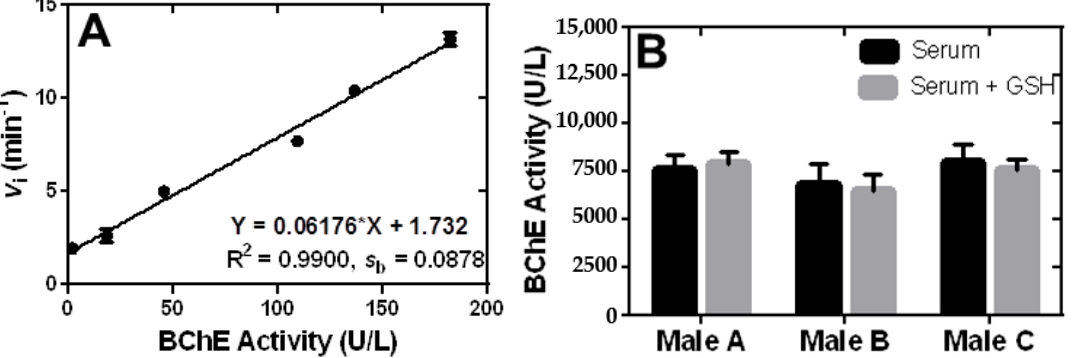
Figure 4. The 11 -based assay for determination of BChE activity in biological samples. ( A ) BChE standards obtained from equine serum were analyzed by the 11 -based analysis to afford the linear regression calibration curve of BChE activity vs. v i and to give LOD of 4.3 U L − 1 and the linear detection range of 4.3–182.2 U L − 1 . ( B ) Serum samples from three healthy males were measured for BChE activity by the 11 -based assay in the presence or absence of spiked 10 μ M GSH.